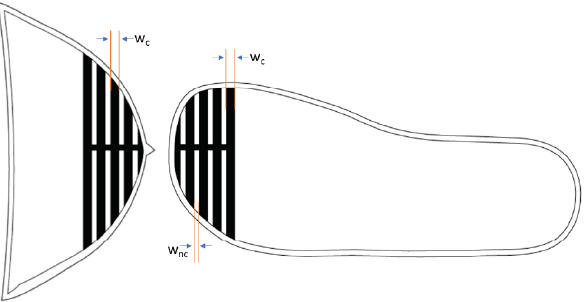
Figure 11. Striped pattern drawn on size-23 toe cap ( right ) and insole ( left ); wc = width of conduc- tive knit, and wnc = width of non-conductive knit.